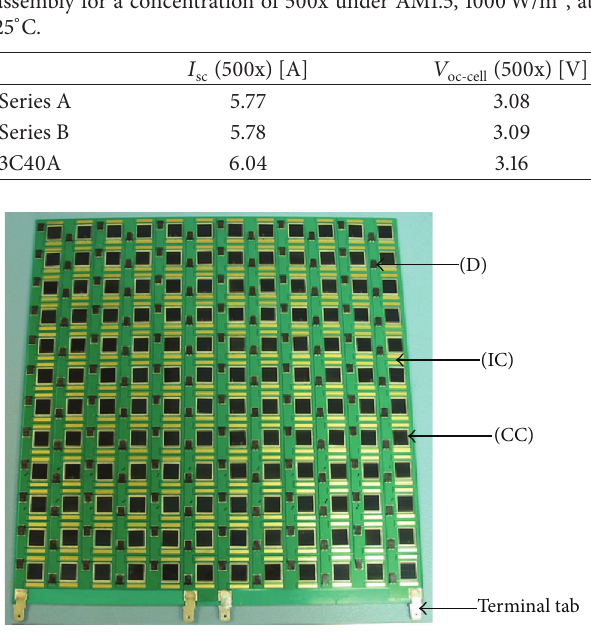
Table 9: Refined electrical outputs of the two series of the produced cell assembly, compared with those of the commercial 3C40A assembly for a concentration of 500x under AM1.5, 1000 W/m 2 , at